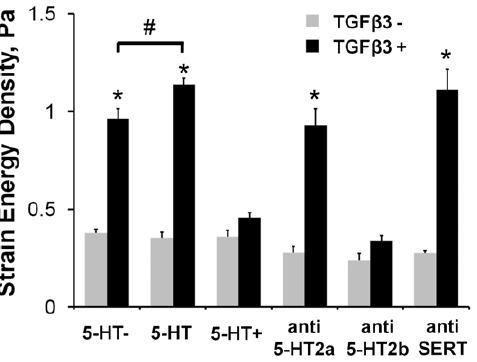
Figure 4. 5-HT signaling modulates TGF b 3 induced AV cushion stiffness. Physiological dosages of 5-HT (470 nM, 5-HT ) exacerbated TGF b 3 stiffening, while elevated dosages (47 m M, 5-HT + ) eliminated it. Molecular inhibition of the 5-HT2a receptor (MDL100907 10 nM, anti-5- HT2a ) and the serotonin transporter (Fluoxetine 10 m M, anti-SERT ) did not affect TGF b 3 mediated biomechanical stiffening. Inhibition of the 5- HT2b receptor (SB204741 35 m M, anti-5-HT2b ) however eliminated the stiffening effect of TGF b 3. mean 6 SEM, n $ 6, *p , 0.0001 t-test relative to control, # p , 0.05 2-way ANOVA with Tukey post-hoc test.